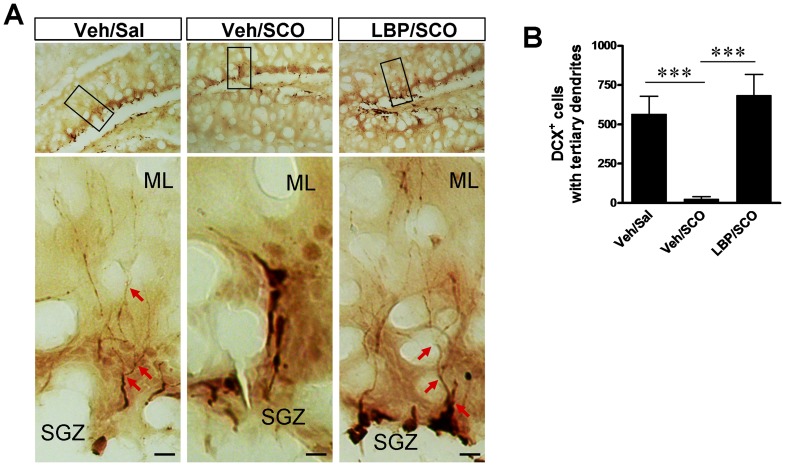
LBP protects the processes of newborn neurons in DG of hippocampus.(A) Representative images of doublecortin (DCX)-positive neuroblasts in the subgranular zone of DG. The lower panels are the enlargement of the frames in the upper panels. The arrows indicates the tertiary neurites of DCX positive neurons in DG. In control vehicle/saline and LBP/SCO groups DCX-immunoreactive neuroblasts have well-developed processes extending to the molecular layer of the DG. SCO treatment (vehicle/SCO group) led to significant reduction of tertiary dendrites. (B) Quantification of number of the DCX-immunoreactive cells with tertiary dendrites in the three groups. Values are means ± SEM (n = 6 animals per groups); ***,P<0.001; scale bars, 50 µm.